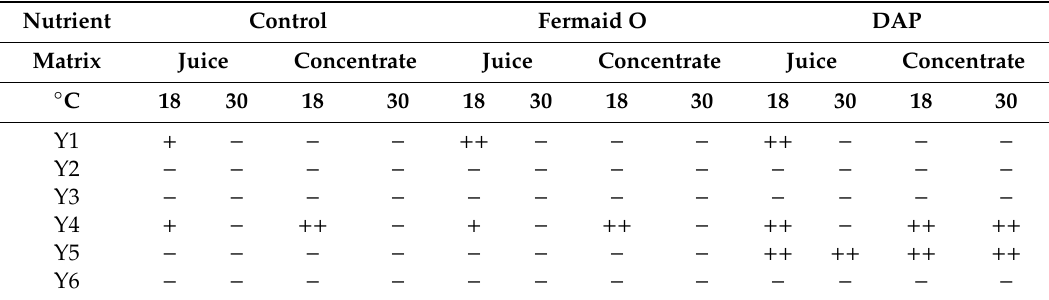
Table 3. Sulfur o ff -flavor occurrence and its intensity in cider samples. − No o ff -flavor